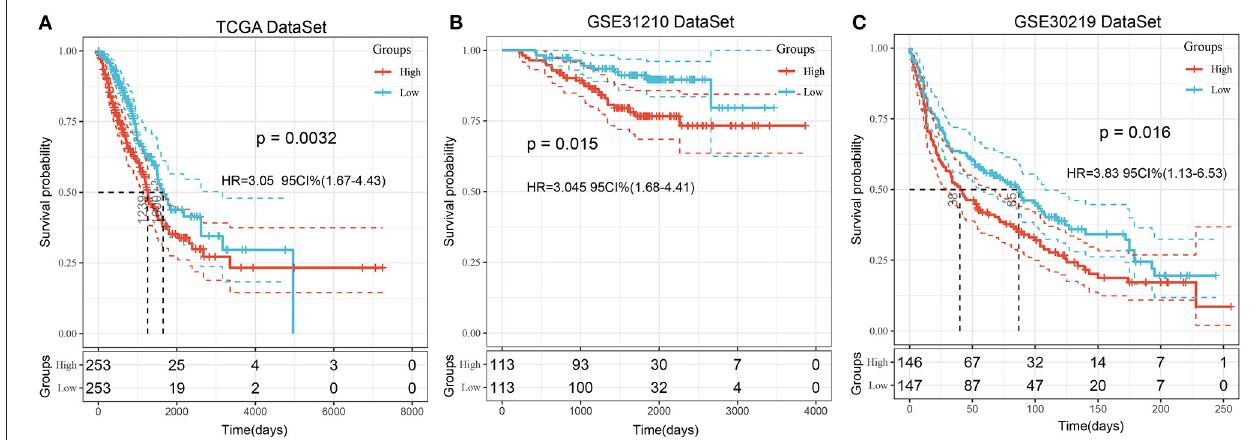
FIGURE 9 | Prognostic signature construction and validation. (A) Significant prognostic differences between groups in the TCGA training cohort. (B) Significant prognostic differences between groups in the testing cohort (GSE31210). (C) Significant prognostic differences between groups in the external validation cohort of GSE30219. Abscissa represents survival time (days), ordinate represents overall survival, the p -value represents the significance of gene combinations with different expression for the prognosis classification of LUAD. Log rank p -test was